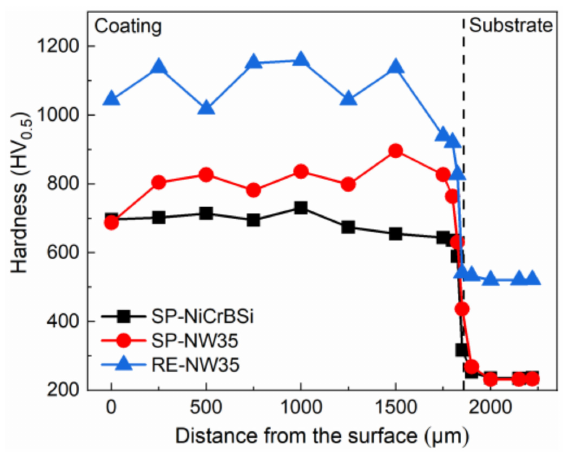
Figure 4. Hardness of the cross-section of the SP-NiCrBSi, SP-NW35 and RE-NW35